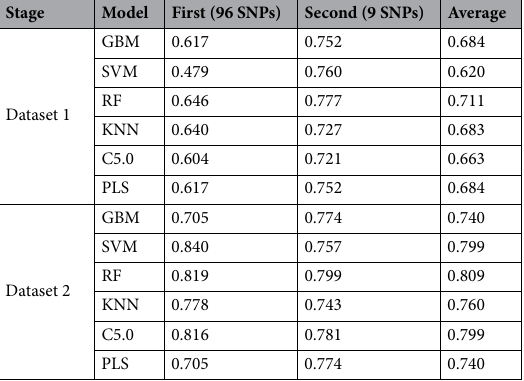
Table 1. Predictions accuracy of six ML models on the two datasets.